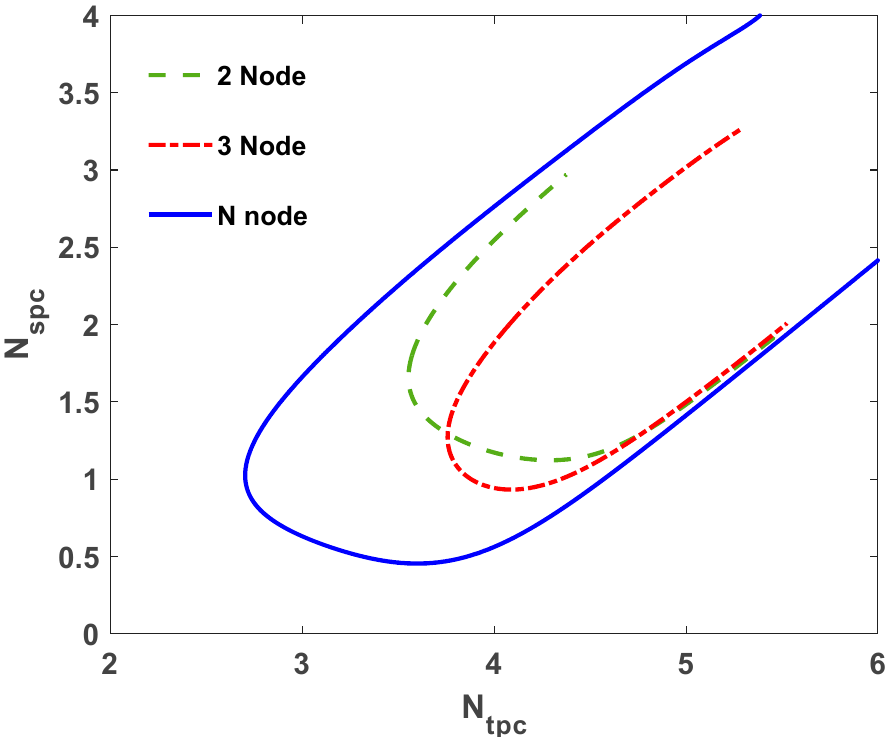
Figure 9. Stability characteristics of three parallel channels using a different node approach.